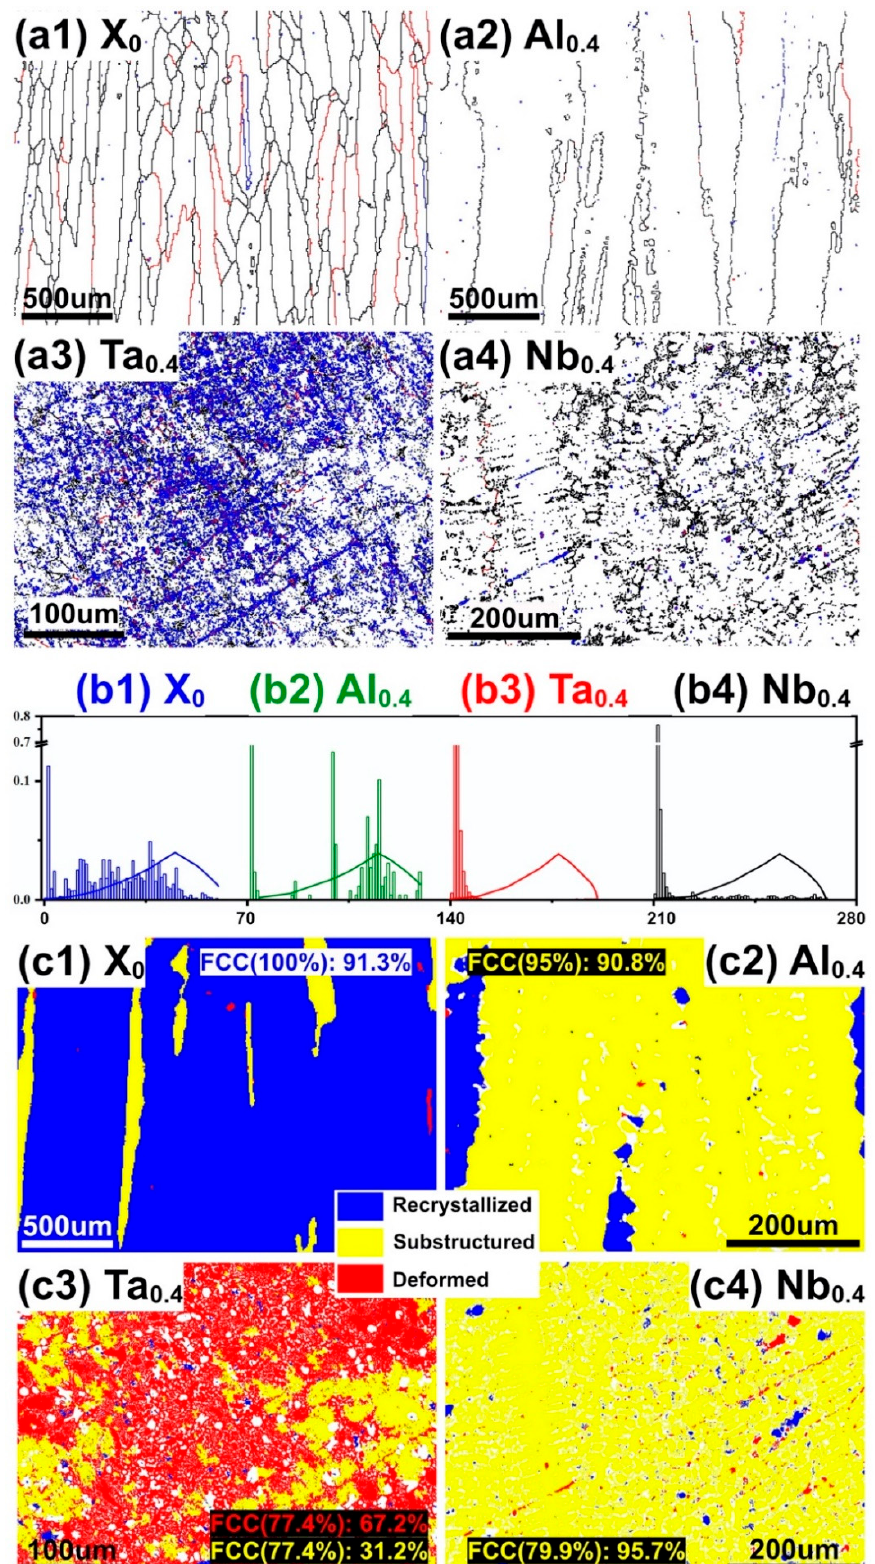
Figure 8. ( a ) Grain boundary of (a1) CoCrFeNi, (a2) CoCrFeNiAl 0.4 , (a3) CoCrFeNiTa 0.4 , (a4) CoCrFeNiNb 0.4 , ( b ) misorientation angle distribution of (b1) CoCrFeNi, (b2) CoCrFeNiAl 0.4 , (b3) CoCrFeNiTa 0.4 , (b4) CoCrFeNiNb 0.4 , and ( c ) DefRex map of (c1) CoCrFeNi, (c2) CoCrFeNiAl 0.4 , (c3) CoCrFeNiTa 0.4 , (c4) CoCrFeNiNb 0.4